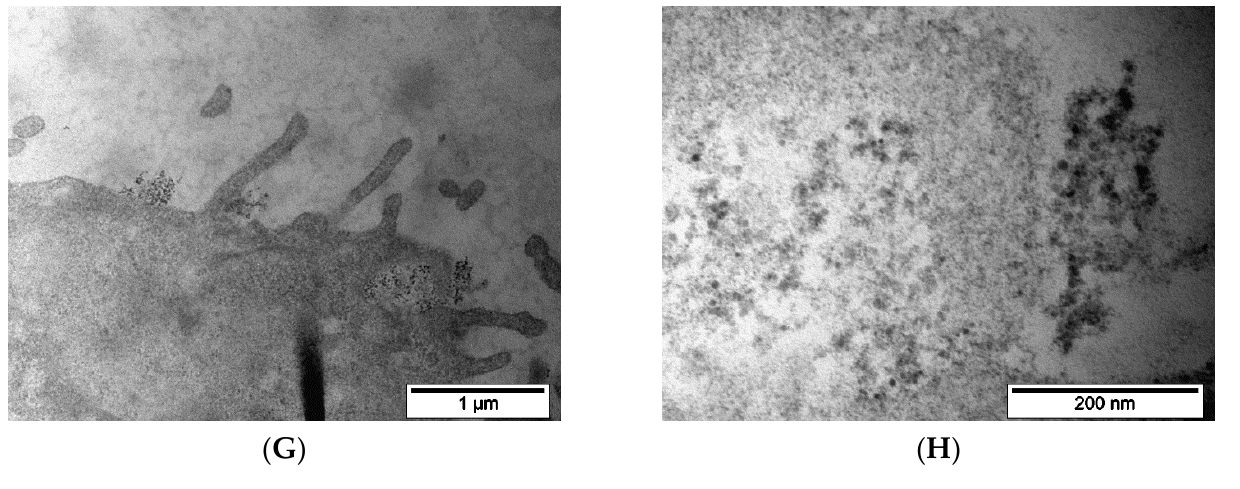
Figure 8. TEM images of the 4T1 cells after 2 h incubation with MNP-SS ( A – D ) and MNP-PEG ( E – H ): ( A )—cytoplasm of 4T1 cell with a vesicle filled with MNP-SS nanoparticles; the vesicle is enlarged in ( B , C )—outer membrane and cytoplasm of the 4T1 cell with attached clumps of MNP-SS nanoparticles and just formed vesicles; the vesicle is enlarged in ( D )—filled with nanoparticles; ( E )—4T1 cell plasmalemma with attached MNP-PEG nanoparticles, enlarged in ( F – H )—MNP-PEG nanoparticles in the vicinity of the 4T1 cell plasmalemma.